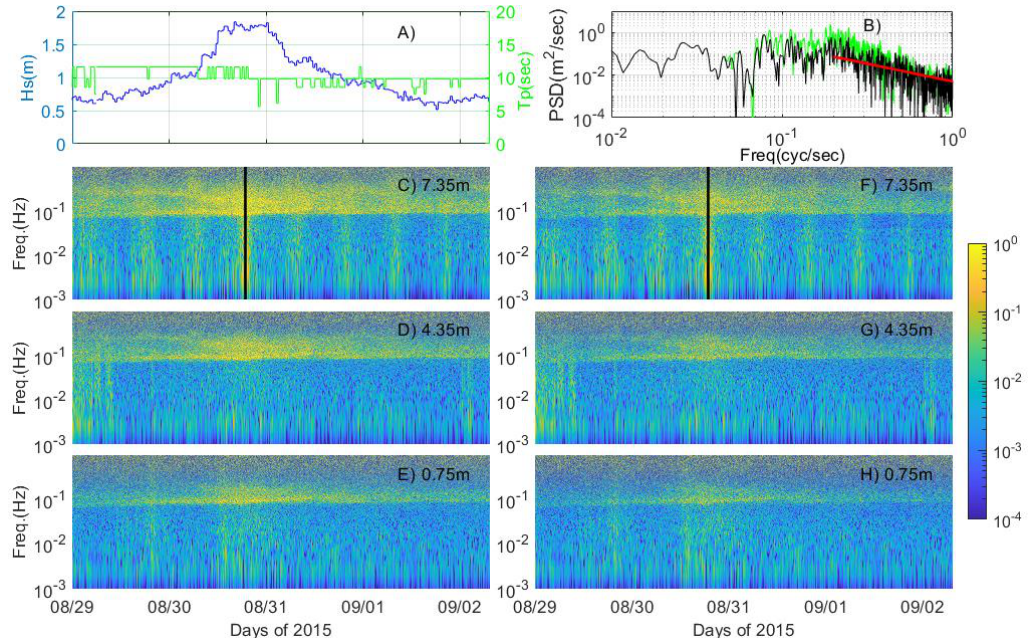
Figure 10. Data from a shoal o ff Cape Canaveral, Florida. ( A ) Significant wave heights (H s ) with a blue solid line marked on the left of the y -axis and dominant wave period (T P ) marked on the right of the y -axis. ( B ) The PSD corresponding to the black vertical line in ( C ) and ( F ). The green and black line denotes the PSD of original data and 95% wave-removed data, respectively. Red line is a reference line for –5/3. The PSD of original data are shown ( C ) at 7.35 m, ( D ) at 4.35 m, and ( E ) at 0.75 m height. The PSD of 95% wave-removed data are given ( F ) at 7.35 m, ( G ) at 4.35 m, and ( H ) at 0.75 m height. Turbulent Kinetic Energy estimated with 95% and 100% wave removal (for all depths) indicates the sensitivity of the method to the percentage of wave removal. This is assessed through a rough TKE budget (Figure 11). The black dotted line has a slope of 1. Data falling on that line would indicate no wave elimination from the total TKE budget. The red and blue circles denote that the HA method reduces wave energy from the total TKE because they fall below the straight line. Turbulent Kinetic Energy with corrected data is reduced by approximately 50% for every 10-min ensemble, compared with original data (Figure 11). The difference between a 95% and a 100% wave removal is determined by the linear fit lines (red and blue). The mean slope is approximately 0.02 larger for the 95% removal (red line) than the 100% removal (blue line). This indicates that the HA method of 100% wave removal reduces 2% more wave energy than the 95% wave removal. However, the time to reconstruct harmonics with HA-100% was 10.5 times longer than the time taken by HA-95%. In this study, the difference between HA-95% and 100% was barely noticeable. The user of the HA approach may determine the most convenient implementation of wave percentage to remove. From these results, the HA method performs well under energetic wave conditions and in the surface boundary layer, where the VAF method would be inadequate.